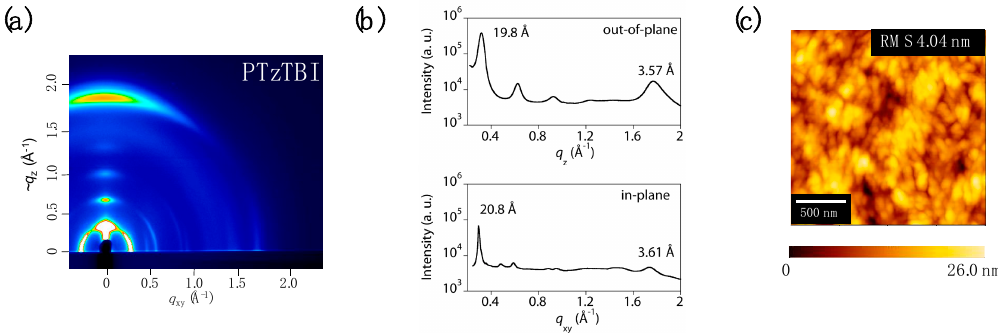
Figure 4. ( a ) 2D GIXD image of the PTzTBI film on the ODTS-modified Si/SiO 2 substrate. ( b ) Cross-section profiles along the q z and q xy axes in the 2D GIXD image. ( c ) AFM image of the PTzTBI film.